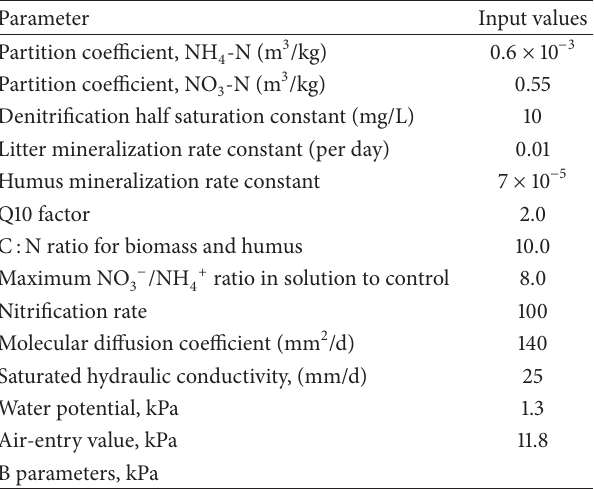
Table2:InputparametervaluesusedintheLEACHMmodelduring